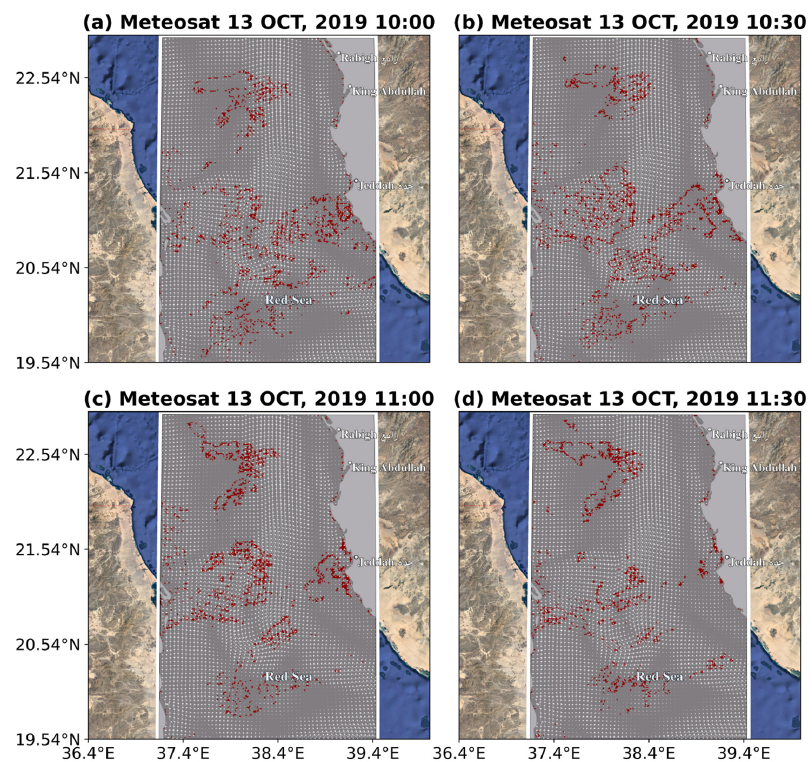
Figure 10. Snapshots of Meteosat detected oil contours, after removing clouds, overlaid on model surface currents at ( a ) 10:00, ( b ) 10:30, ( c ) 11:00, and ( d ) 11:30 UTC on 13 October 2019.